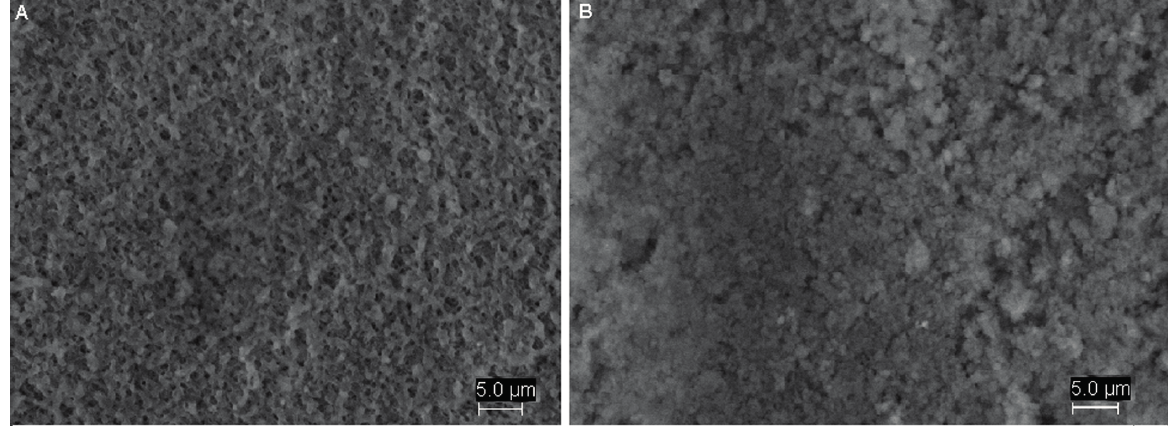
Figure 1. SEM images of the PVDF membrane ( A ) and MIM ( B